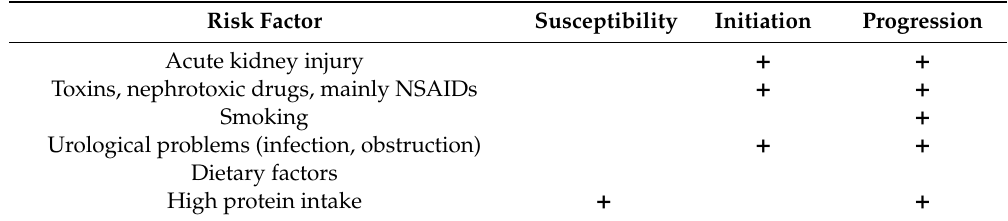
Table 1. Cont. Risk Factor Susceptibility Initiation Progression Acute kidney injury Toxins, nephrotoxic drugs, mainly NSAIDs Smoking Urological problems (infection, obstruction) + Dietary factors High protein intake +